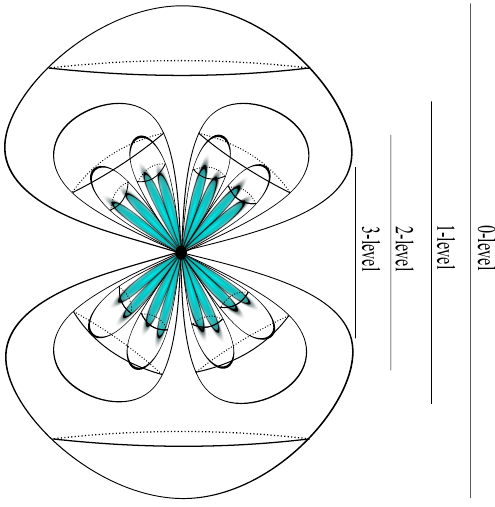
Figure 17. Homeomorphic representation of the union of the levels of